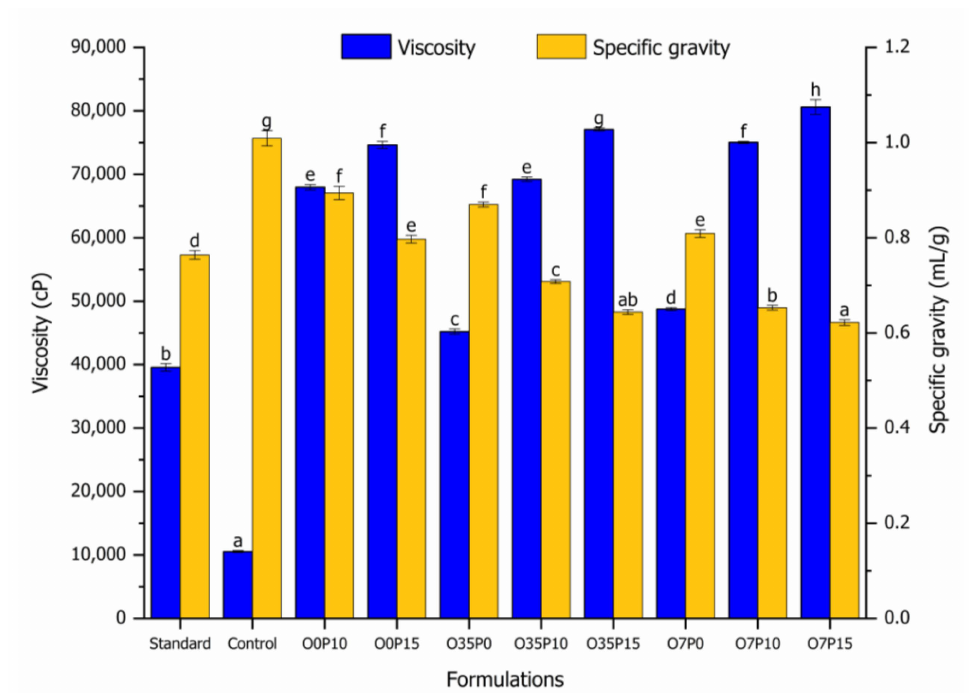
Figure 1. Viscosity (cP) and specific gravity (mL/g) for different formulations of cake batter. His- togram with different alphabet (a–h) indicates significant difference ( p <